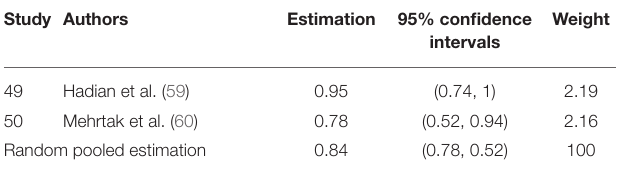
TABLE 3 | The results of pool estimation for technical efficiency among Iranian